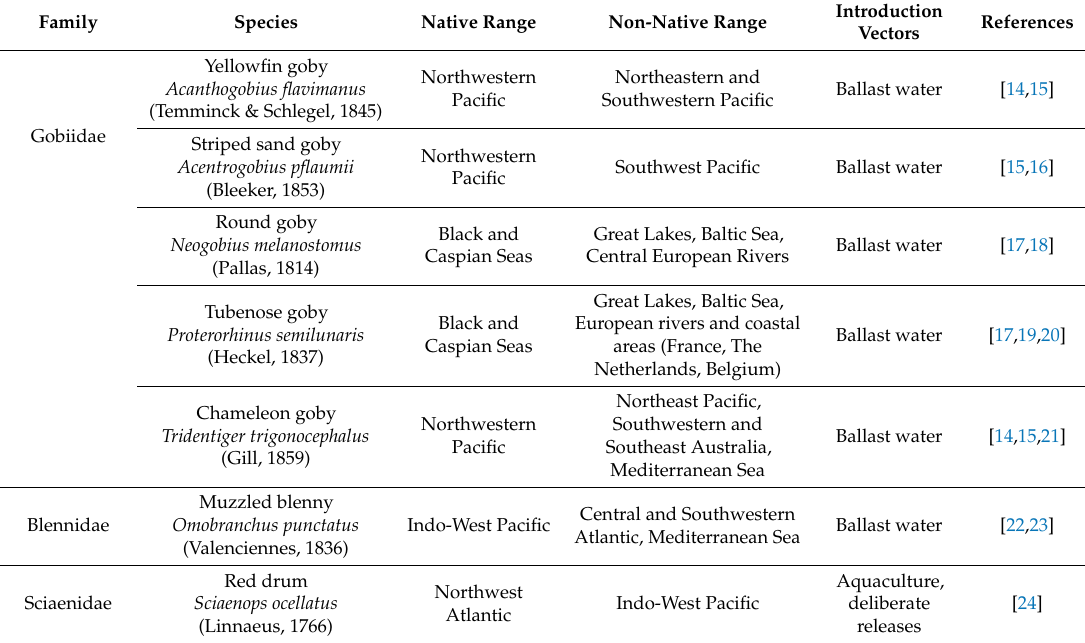
Table 1. List of non-native fish species introduced in marine and brackish water ecosystems in multiple locations through independent events. This table is a modified and updated version of a table presented by Wonham et al.